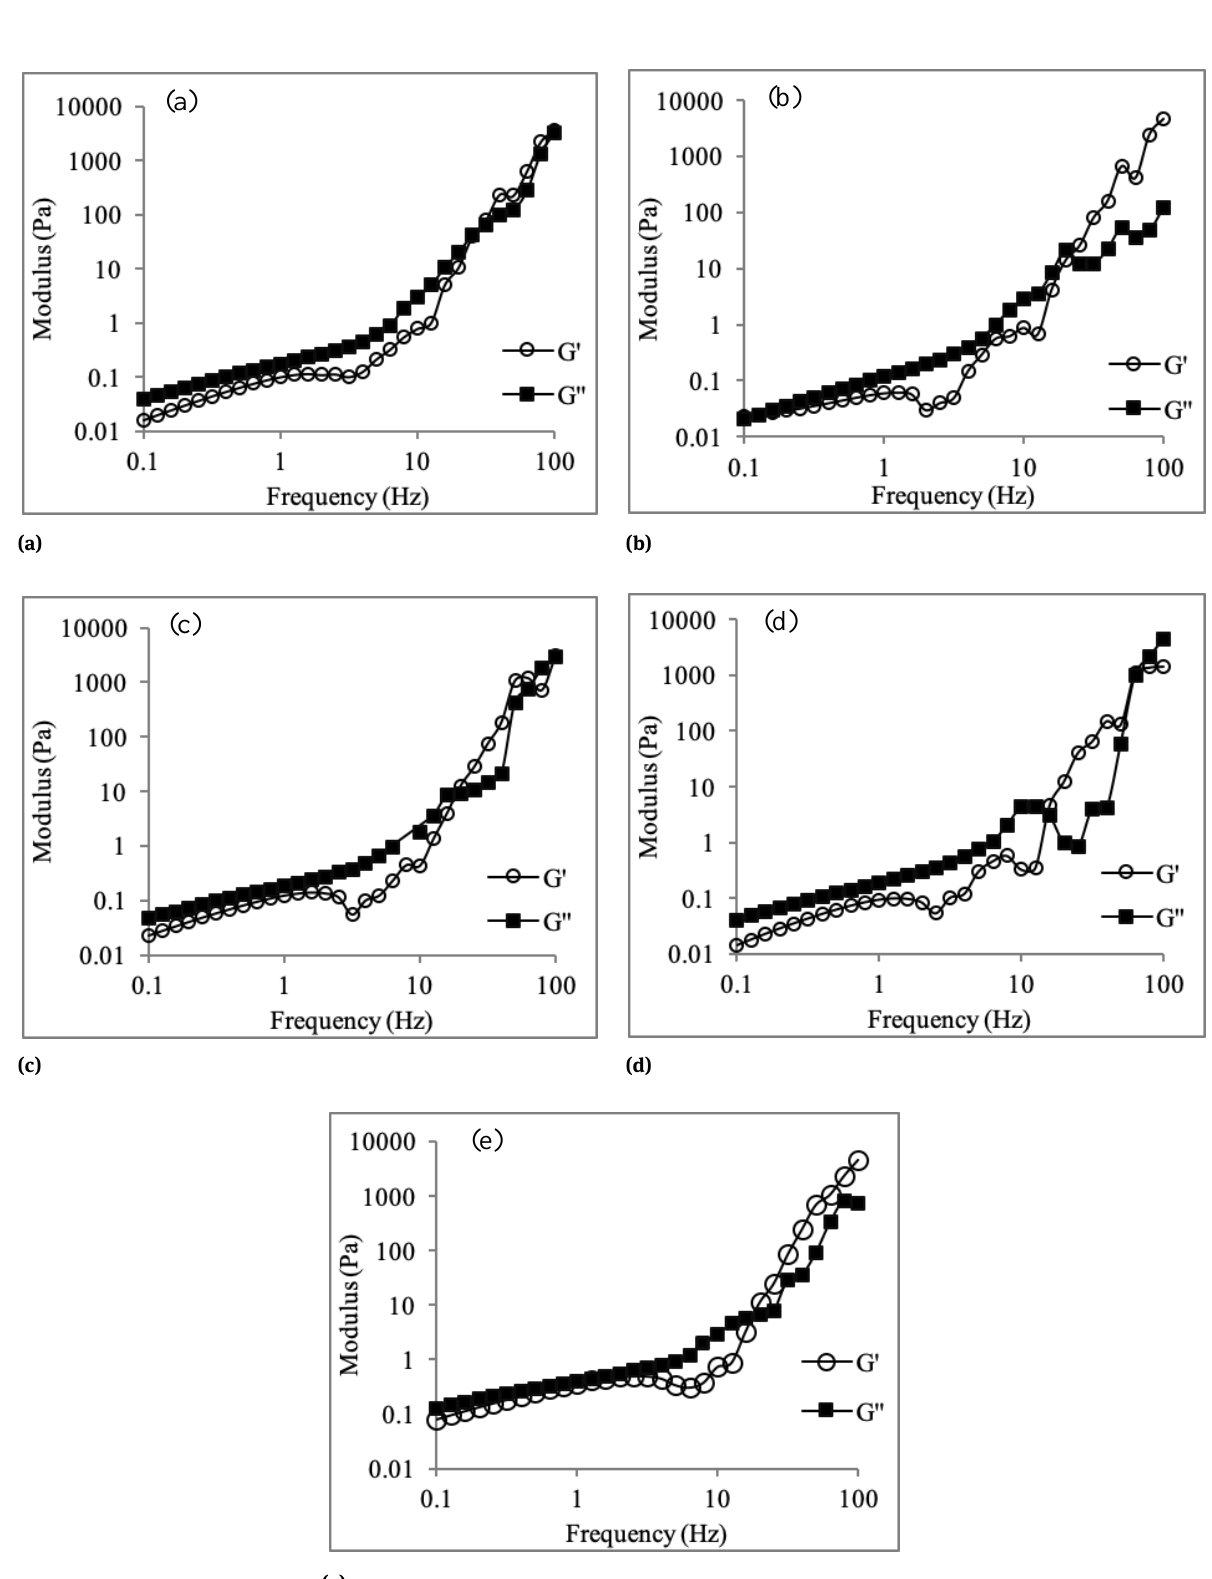
Figure 3: Viscoelasticity curves of the chitosan–SLES complexes at the concentrations of (a) 50–400 ppm, (b) 150–400 ppm, (c) 300–400 ppm, (d) 600–400 ppm, and (e) 800–400 ppm as a function of sweep